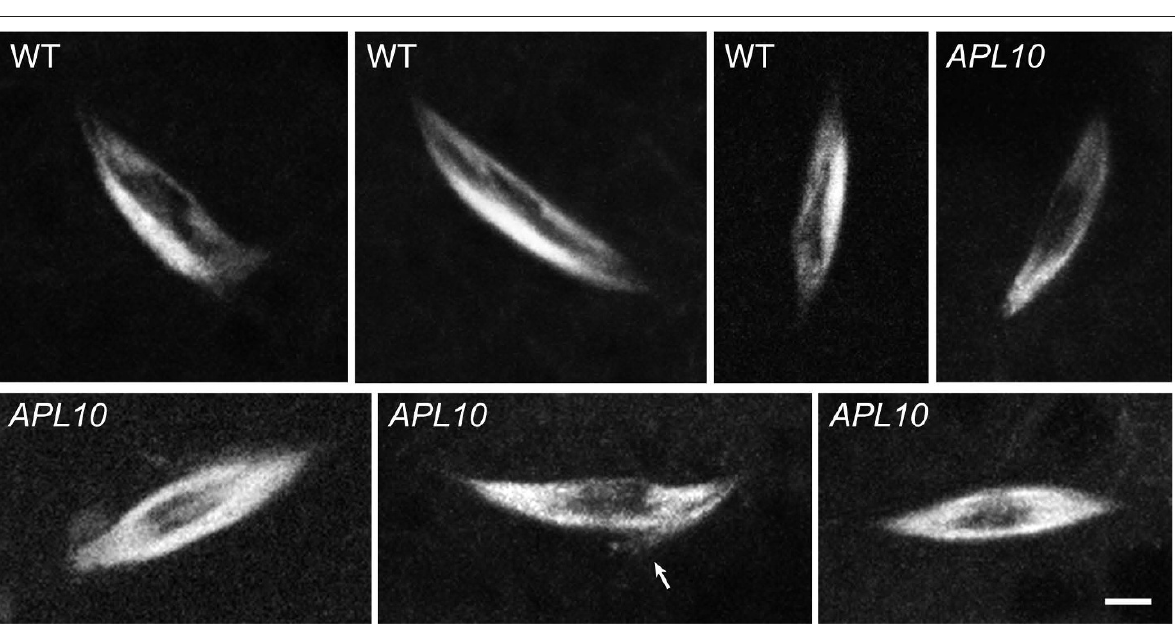
Figure 2 MI spindles in g Tub37C APL10 mutant oocytes . g Tub37C APL10 mutant oocytes contained bipolar MI spindles, many of which were normal, resembling those in wild-type (WT) oocytes, although some were frayed (arrow) or had split poles (not shown). Spindles visualized by Ncd-GFP. Bar, 3 μ